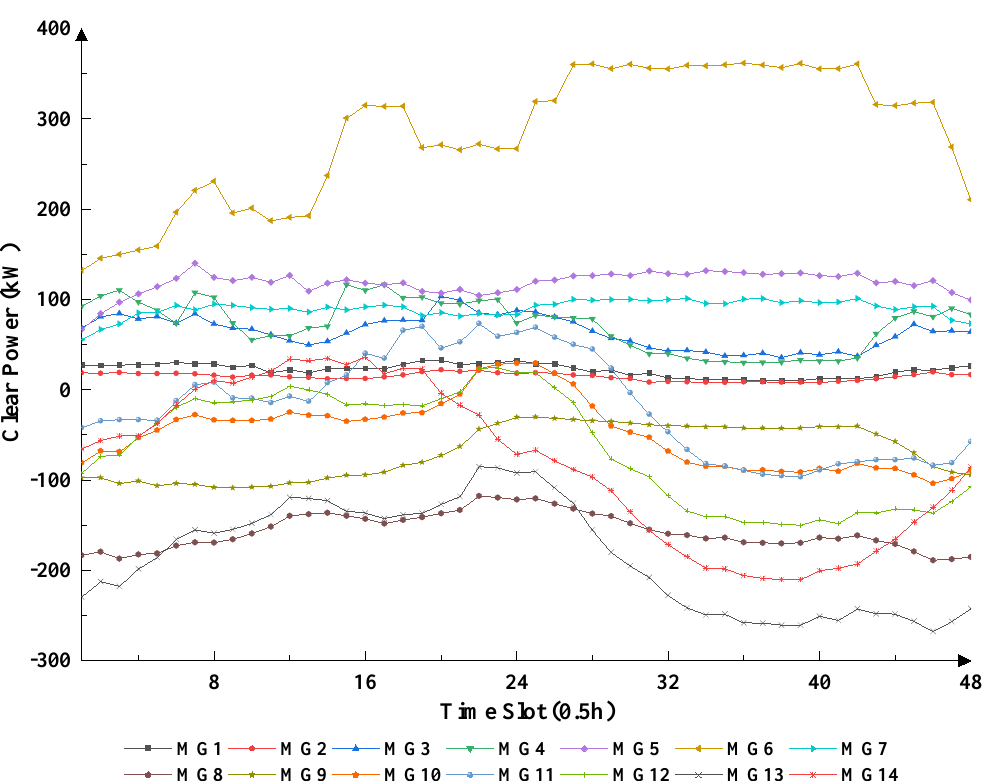
Figure A1. Power of 14 microgrids in Guizhou Province,